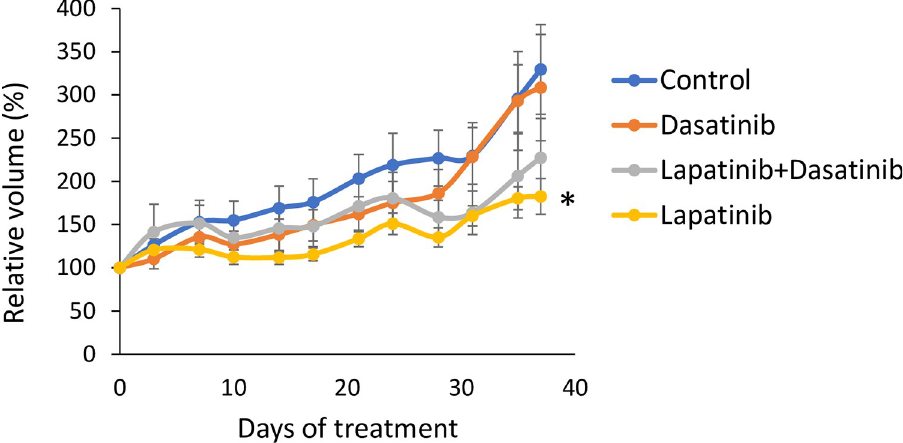
Fig 6. Treatment efficacy of lapatinib and dasatinib in vivo . Nude mice with bilateral KPL4 tumors were treated daily with lapatinib (100 mg/kg), dasatinib (10 mg/kg), a combination of both drugs, or vehicle. The figure shows relative tumor volumes (%) compared to volume at the start of treatment. Error bars indicate standard error of the mean, n = 6 mice per group. � p < 0.05 between treatment group and control, Wilcoxon rank sum test.